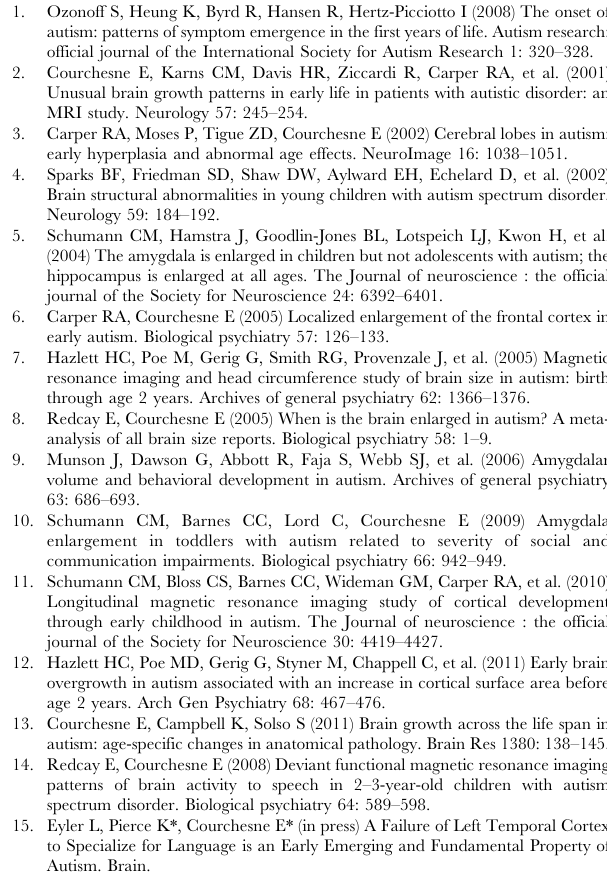
Table S9 References for genes in noted pathways and networks. Important genes from the pathways and networks identified by gene expression analyses are listed. Gene category, references, and analysis corresponding to these genes are presented. Gex= gene expression. Text S1 Supporting materials. Supplementary methods,